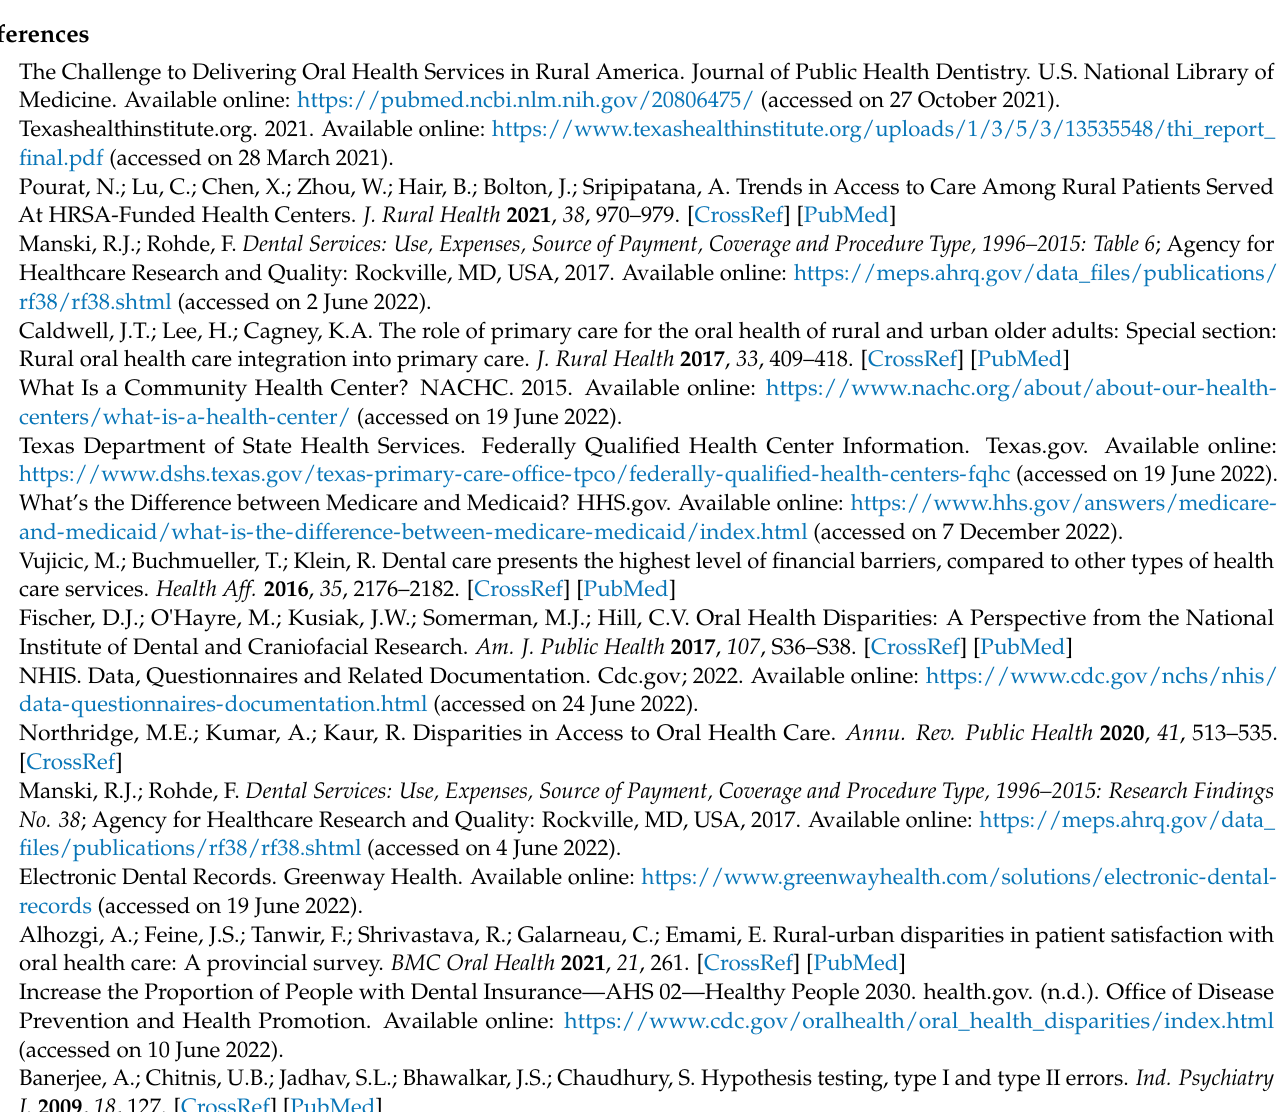
Figure A1. Data merging to convert the patient’s clinical encounters to patient visits.